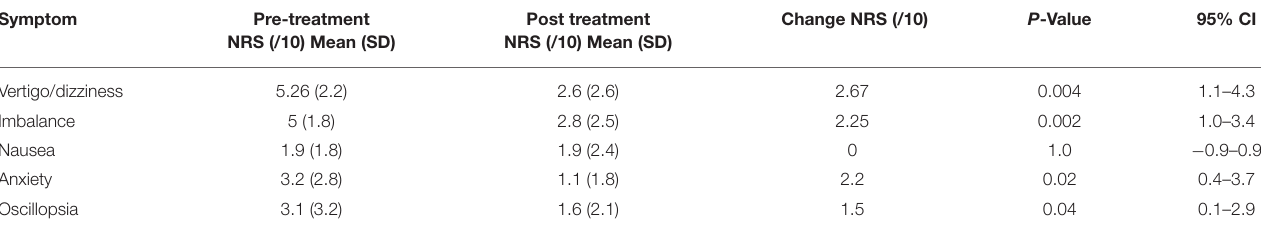
TABLE 2 | Mean change in numerical rating scale scores of subjective symptoms, where 0 is “no symptoms” and 10 is marked as “symptoms as bad as they can be.”